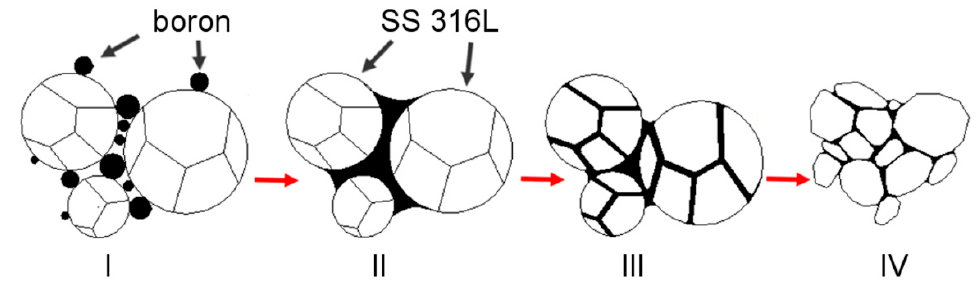
Figure 13. Microstructural phenomena occurring during the sintering process of boron-doped samples (without silicon nitride addition). I : Mixed state; II : Eutectic liquid creation and primary reorganization; III : Penetration of the grain boundaries; IV: Secondary reorganization.